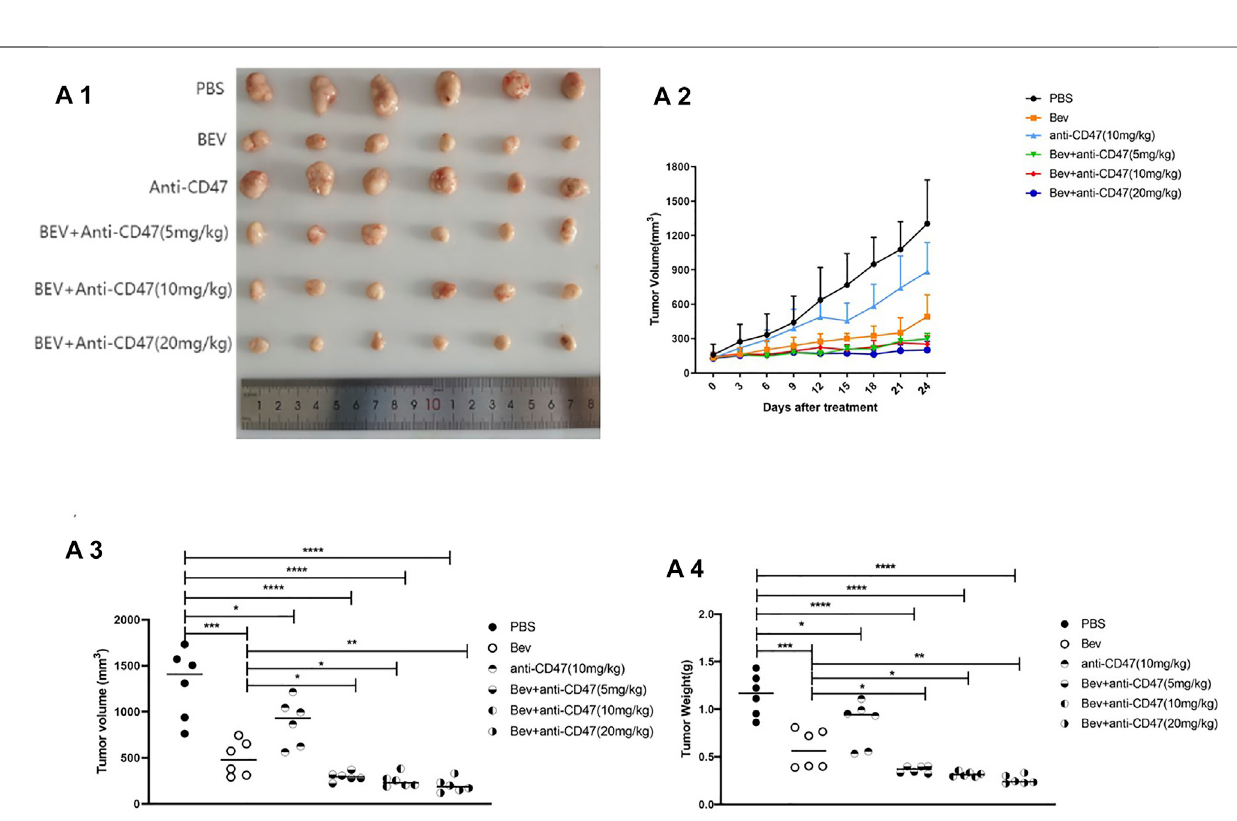
FIGURE3 | Cotargeting CD47 and VEGF elicited synergetic antitumour effects in gastric cancer. (A) In the BGC-823 xenograftmodel, tumour volume and tumour weight are presented (mean ± SD, N = 6 per group). (B) Tumour inhibition was calculated. (C) CD31 immunohistochemistry of tumour sections of BALB/c nude mice after injection for 4 successive administrations. (D) Spontaneous pulmonary metastasis of BGC-823 gastric cancer cells was observed in lung tissue. (E) The change in the mean animal body weight for BALB/c nude mice bearing BGC-823 xenografts treated with different formulations. All the data are presented as the mean ± SD (* p < 0.05, ** p < 0.01, *** p < 0.001, and **** p < 0.0001, ns denotes a statistically nonsigni fi cant difference, p ≥